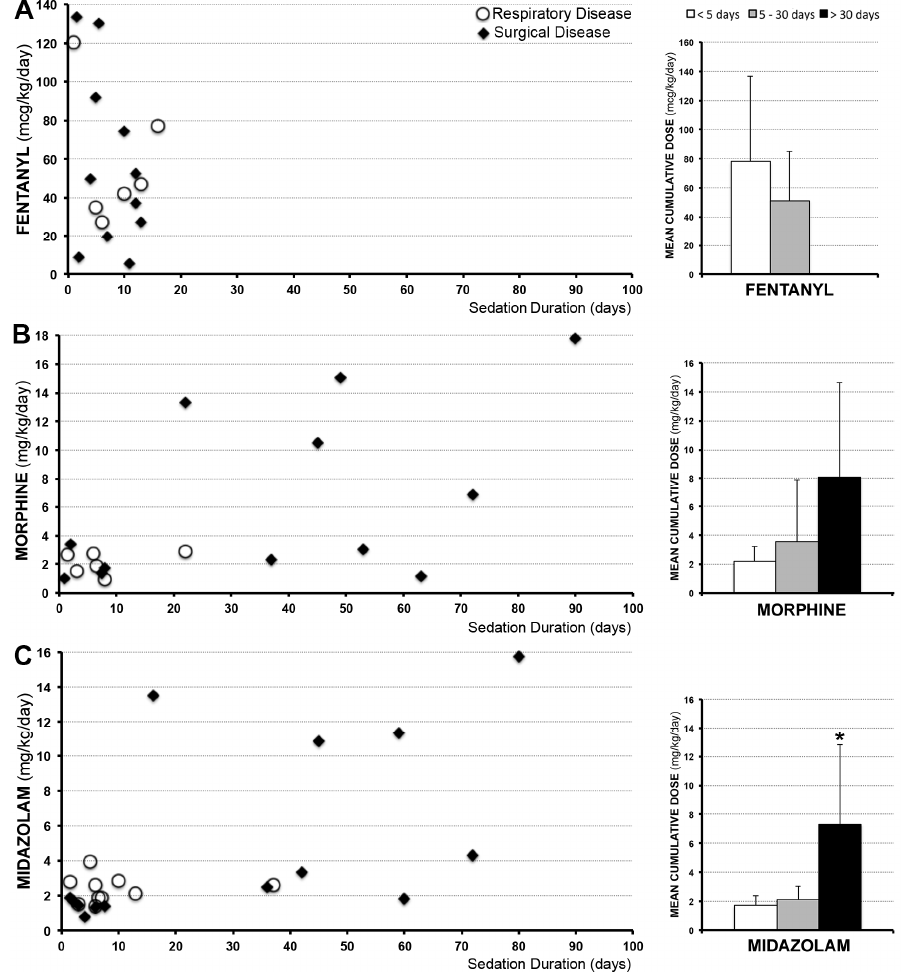
Figure 3. Individual average daily dose of drugs used for sedation. Graphs on the left illustrate individual average daily dose received (unit/kg/day) of medications (fentanyl ( A ), morphine ( B ), and midazolam ( C )) administered to full-term infants treated for either respiratory ( n = 10; white circles) or surgical ( n = 14; black diamonds) disease during a single hospital admission (first or only hospital admission). Patients were selected over a period of one year from a single institution. Individual infants received fentanyl (( A ); n = 17) and/or morphine (( B ); n = 18); not all infants received both. Every infant received midazolam (( C ); n = 24). Note that fentanyl was not administered for longer than 2 weeks. Bar graphs on the right show mean of the individual average daily dose received for both groups across three different arbitrary time periods: <5 days (white), 5–30 days (grey), and >30 days (black). There was no significant difference in mean values for fentanyl ( t = 1.16, p = 0.13) or morphine (F(2,15) = 2.28, p = 0.14) among different time periods. The mean individual average daily dose for midazolam was significantly higher when used for sedation >30 days (F(2,21) = 6.91, p <0.01). Asterisk (*) indicates significant